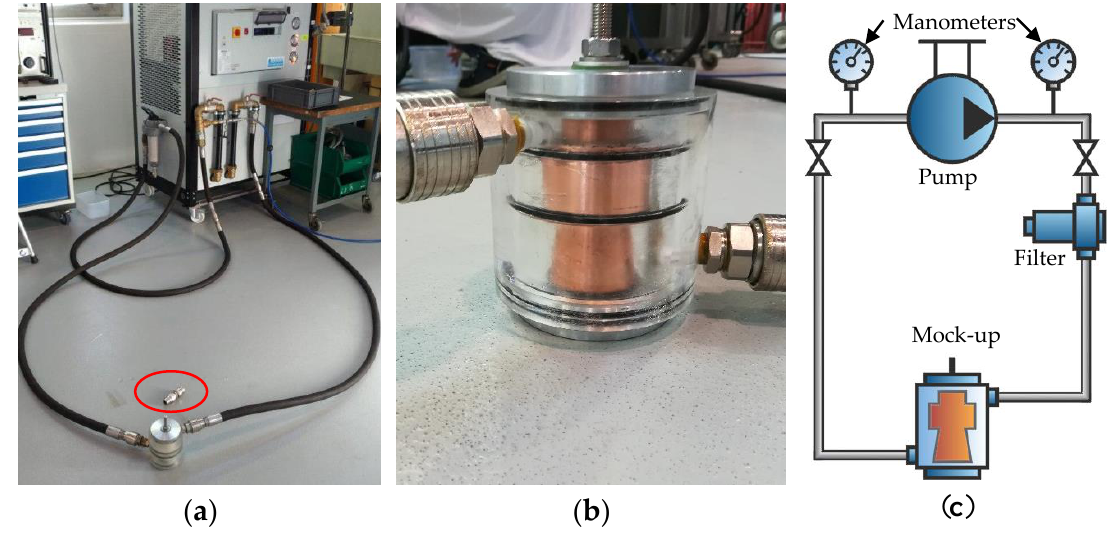
Figure 7. ( a ) Hydraulic test loop with the nylon cavity mock-up equipped with MCs, and, in the red circle, the short hydraulic connector used for the pressure drop calibration; ( b ) mock-up equipped with RR connected to the loop; ( c ) sketch of the loop.